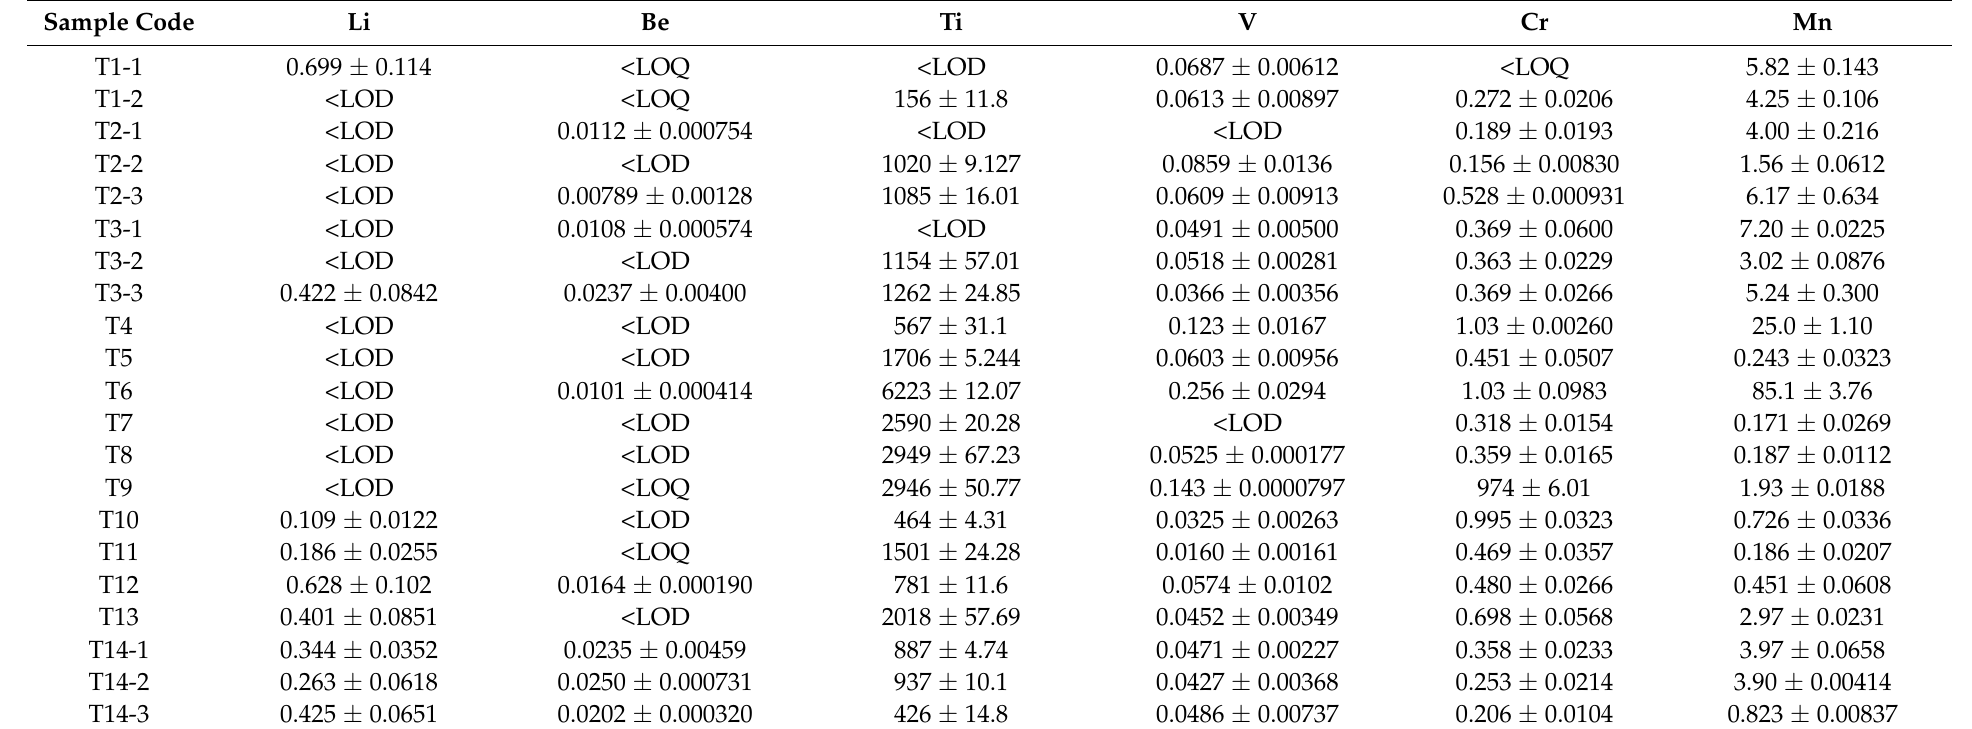
Table 5. Metal concentration ( µ g g − 1 ) in the studied fabrics measured by